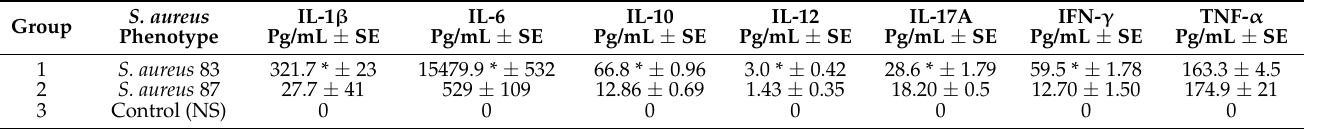
Table 4. Detection of levels of different cytokine biomarkers in sera samples of mice before